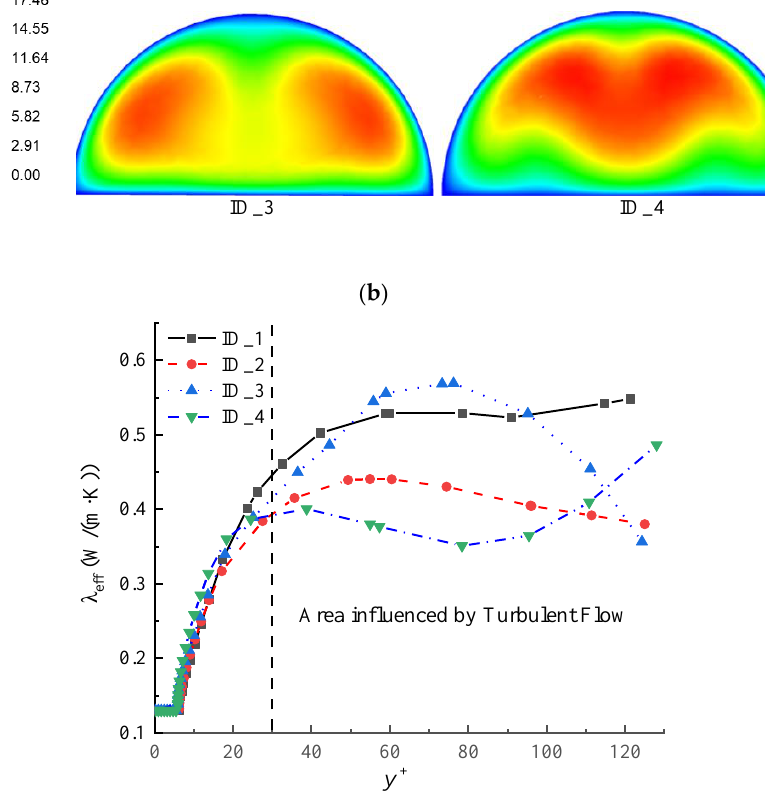
Figure 13. Flow pattern distributions of different at different cross sections, Re in = 2500. ( a ) Cross- sections’ schematic. ( b ) Contours of velocity at a different cross-section. ( c ) Distributions of near-wall effective thermal conductivity at different cross-sections.